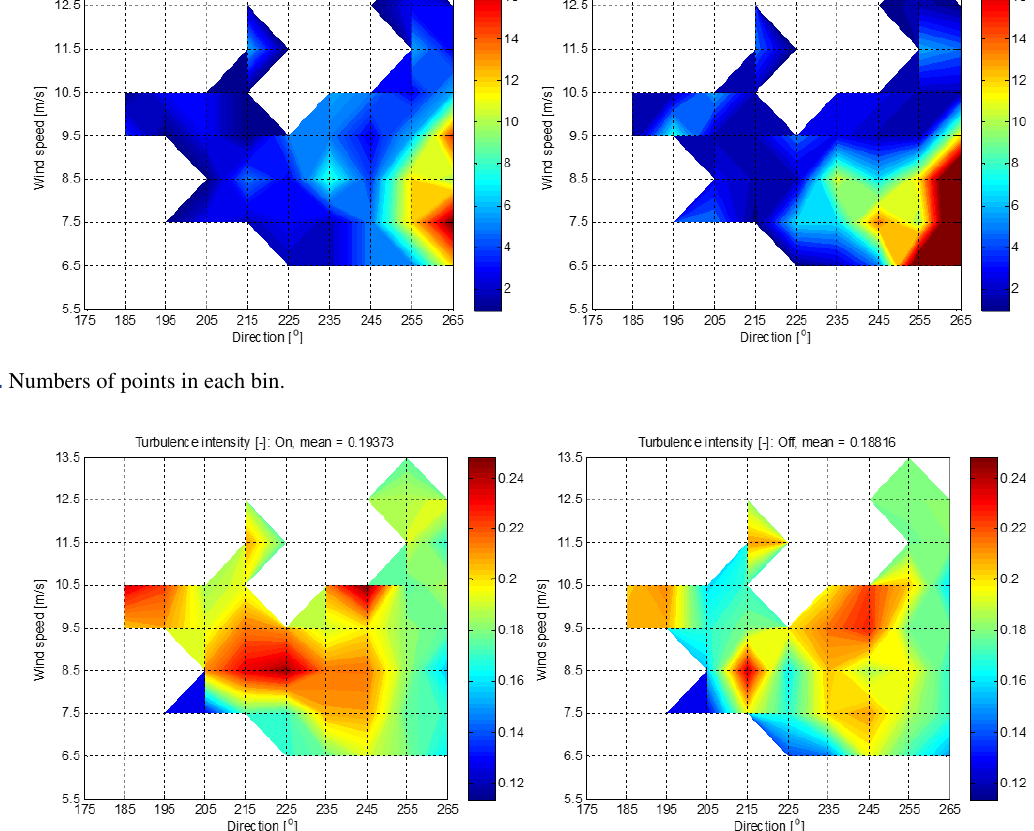
some valid bins which do not show up in the contour plots because they are isolated from neighbouring